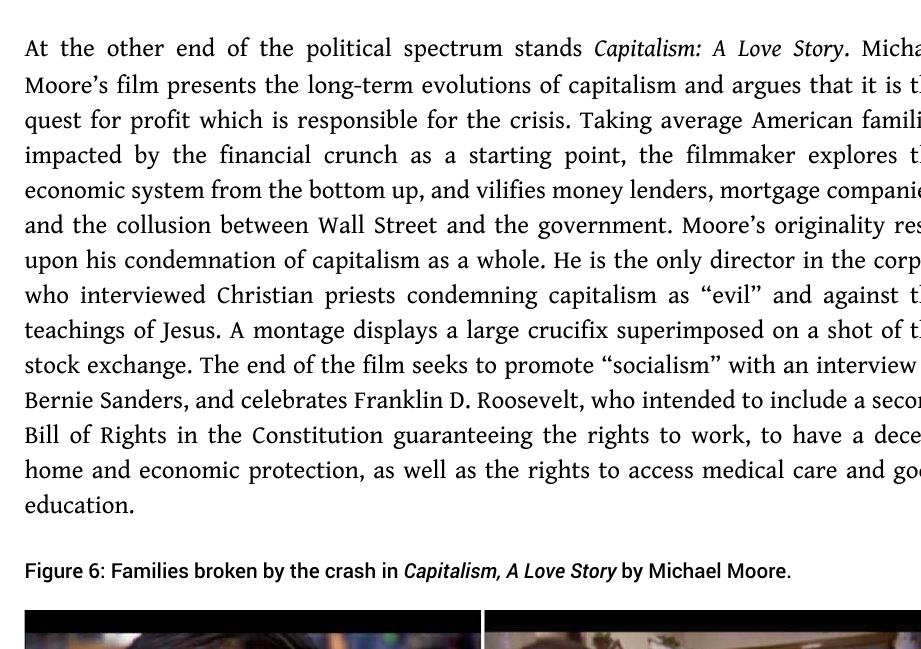
Figure 6: Families broken by the crash in Capitalism, A Love Story by Michael Moore.